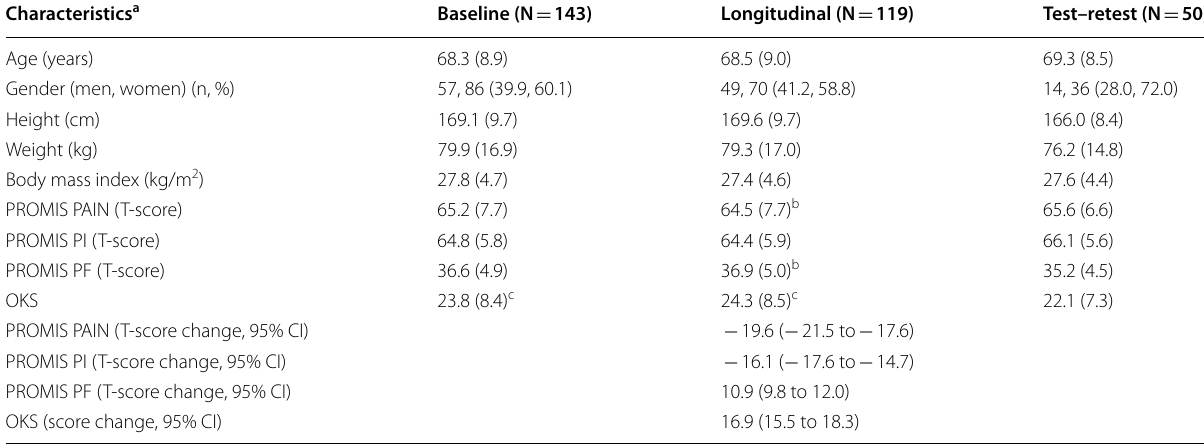
Table 1 Baseline patient characteristics and score changes